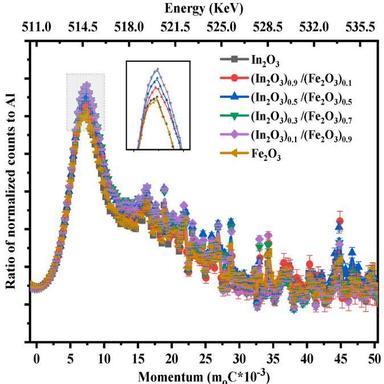
The ratio of intensities for CDB spectra for In2O3 and Fe2O3 and their NCs are obtained by dividing point-by-point, curve-by-curve, with Aluminum metal as reference. Inset: zoom of the selected area.